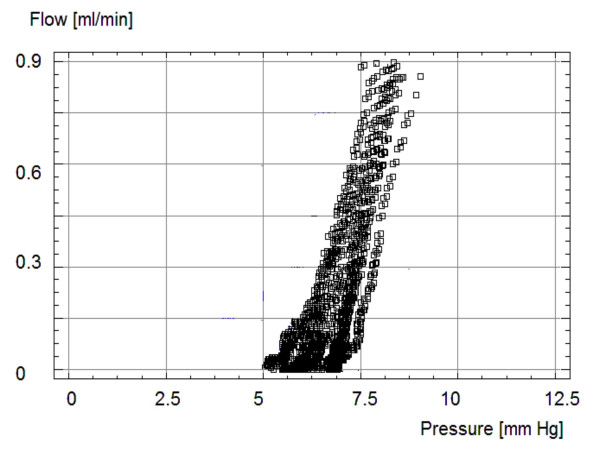
Superimposed pressure-flow curves taken from 10 tests utilizing one shunt at 70 mmH2O (5.2 mmHg). The scatter of the measurement points indicates good agreement over repeated measurements.